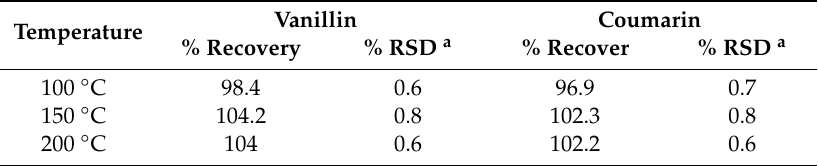
Table 3. Recovery of vanillin and coumarin obtained by 30-min subcritical water extraction of the spiked